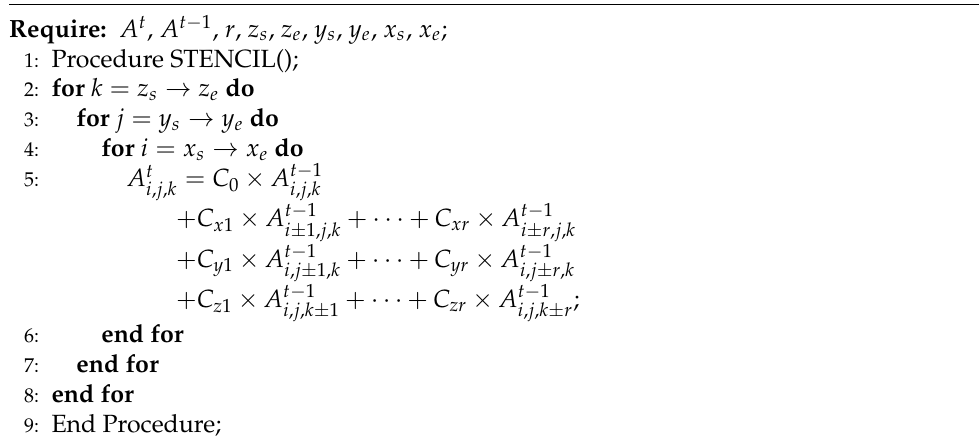
Figure 1. Examples of 3D point stencil. Algorithm 1 The classical stencil algorithm pseudo-code for a 3D problem